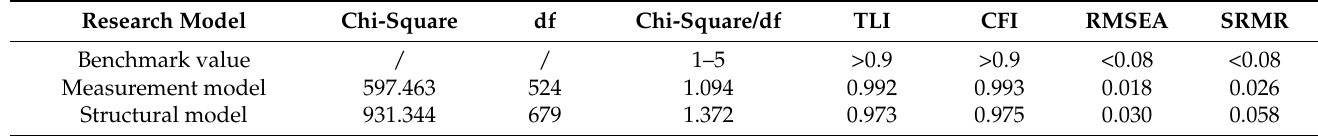
Table 5. Goodness of fit of the models.